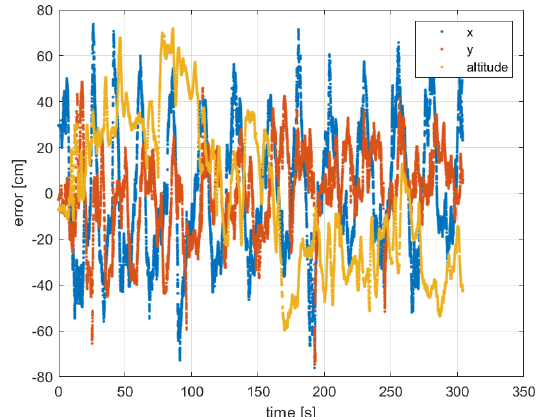
Figure 7. Errors on the UWB position estimates in the Adapt.EKF2